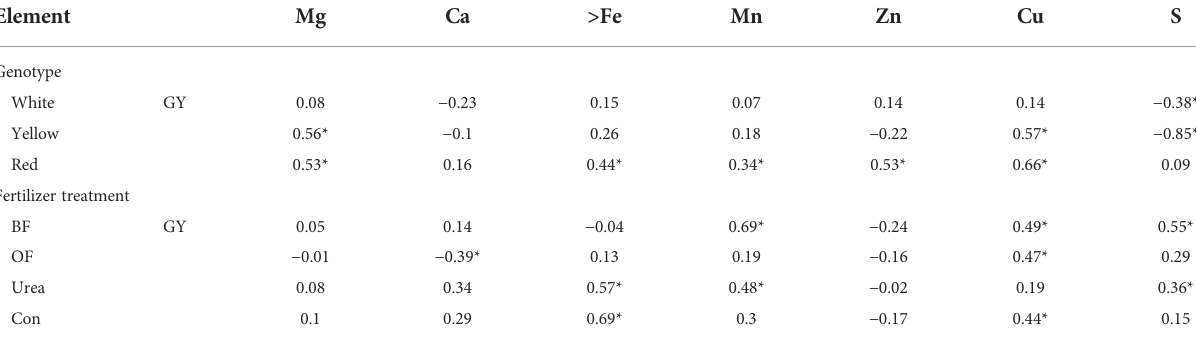
TABLE 4 The correlation between grain yield (GY) and concentrations of the analyzed elements in maize with different kernel colors under different fertilizer treatments [biofertilizer (BF); organic fertilizer (OF); urea; control (Con; no fertilizer)]. Element